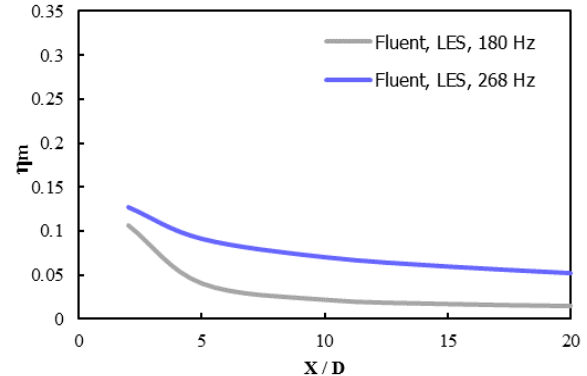
Figure 21. The spanwise-averaged effectiveness obtained using the LES Smagorinsky–Lilly model for M = 0.5 for the 180 and 268 Hz oscillations [28].